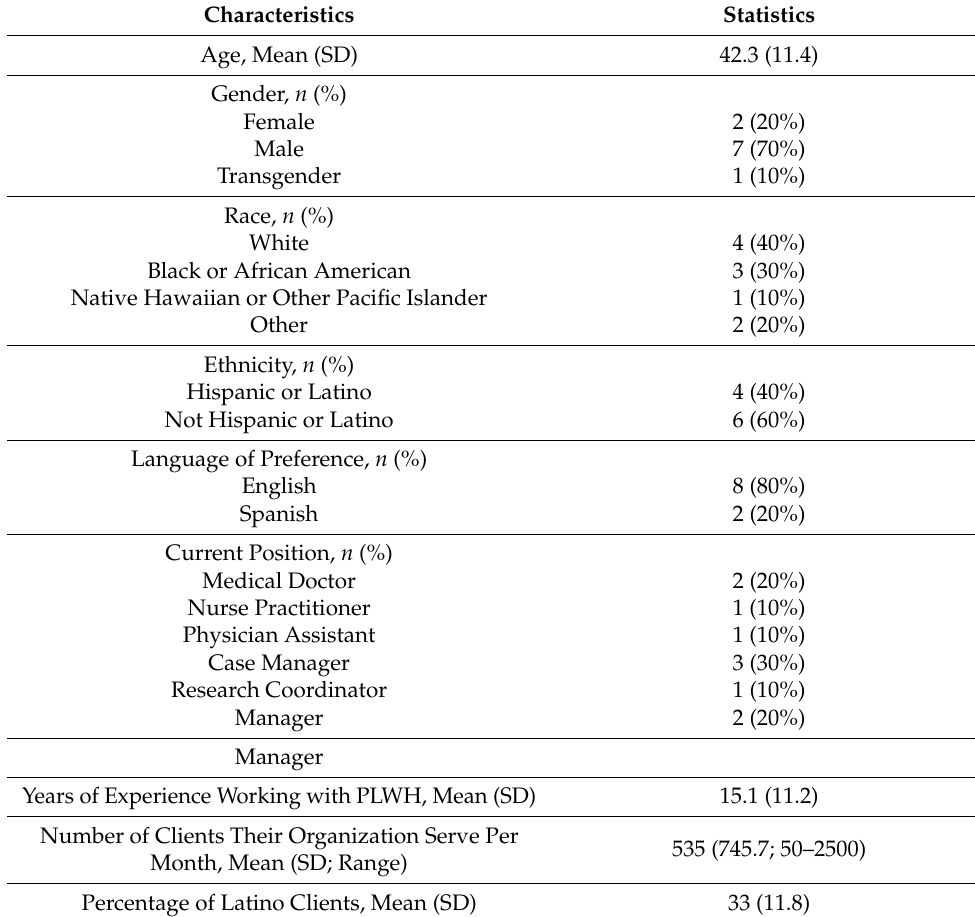
Table 3. Baseline characteristics of participants ( n =